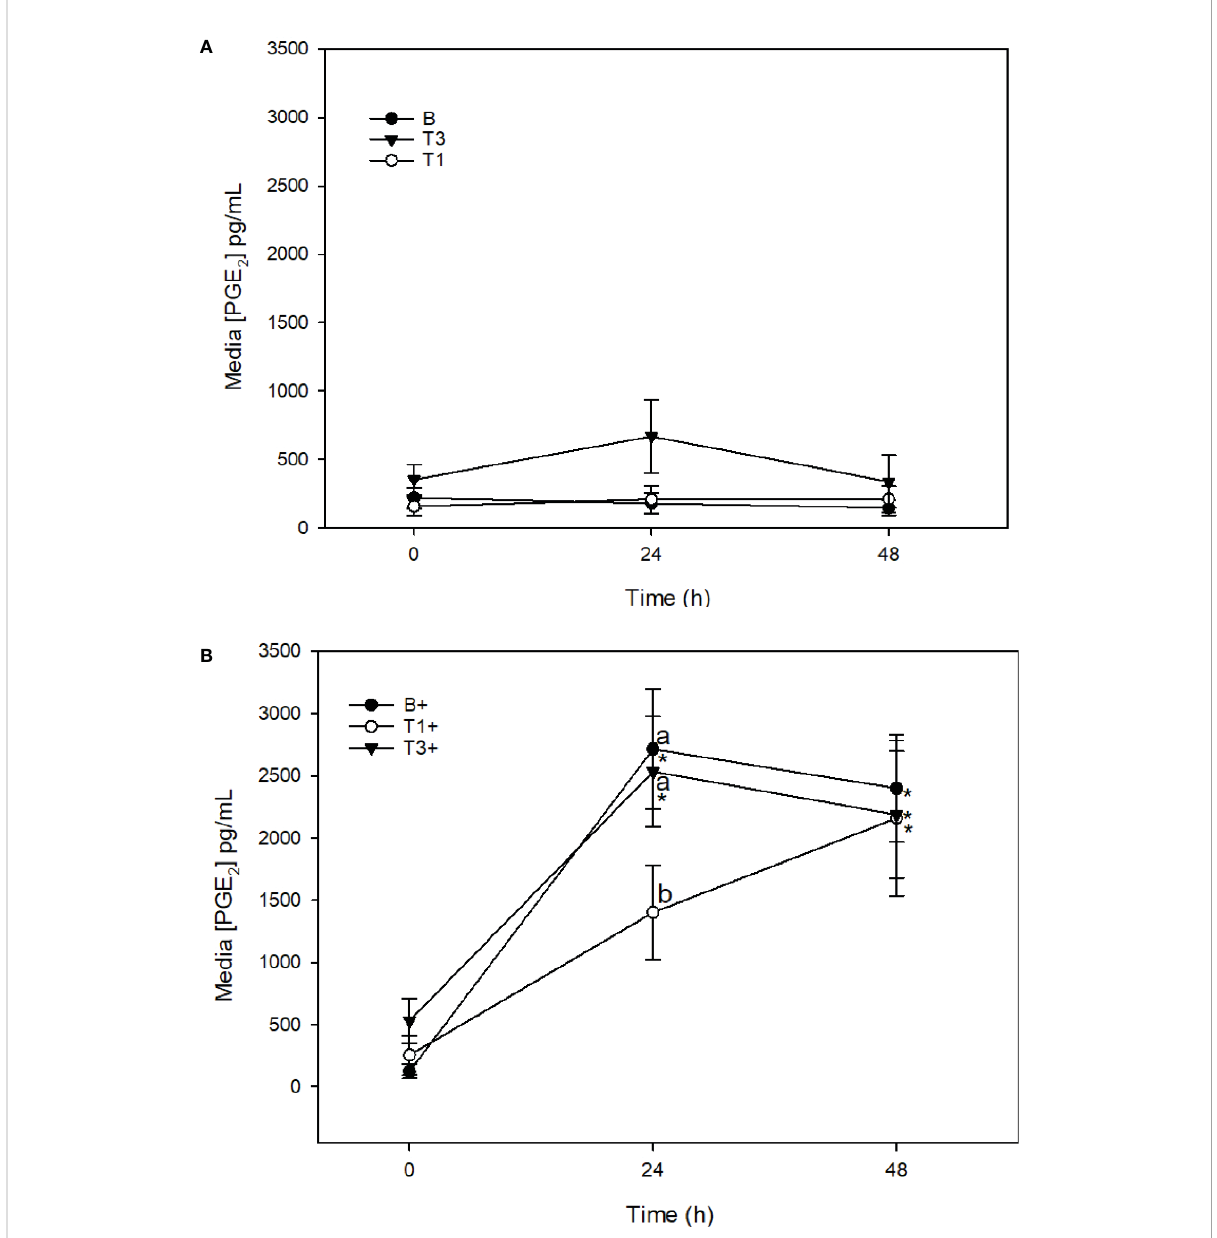
FIGURE 7 Media [PGE2] (µg/mL) from expalnts cultured in basal media (B) or media conditioned with 5 (T1) or 15 (T3) µg/mL of Wheatgrass Extract. Explants were maintained without stimulation (A) or were stimulated with lipopolysaccharide (10 µg/mL; denoted as ‘ + ’ ) (B) . *denotes signi fi cant change from baseline within treatments. Letters denote signi fi cant difference between treatments at individual time